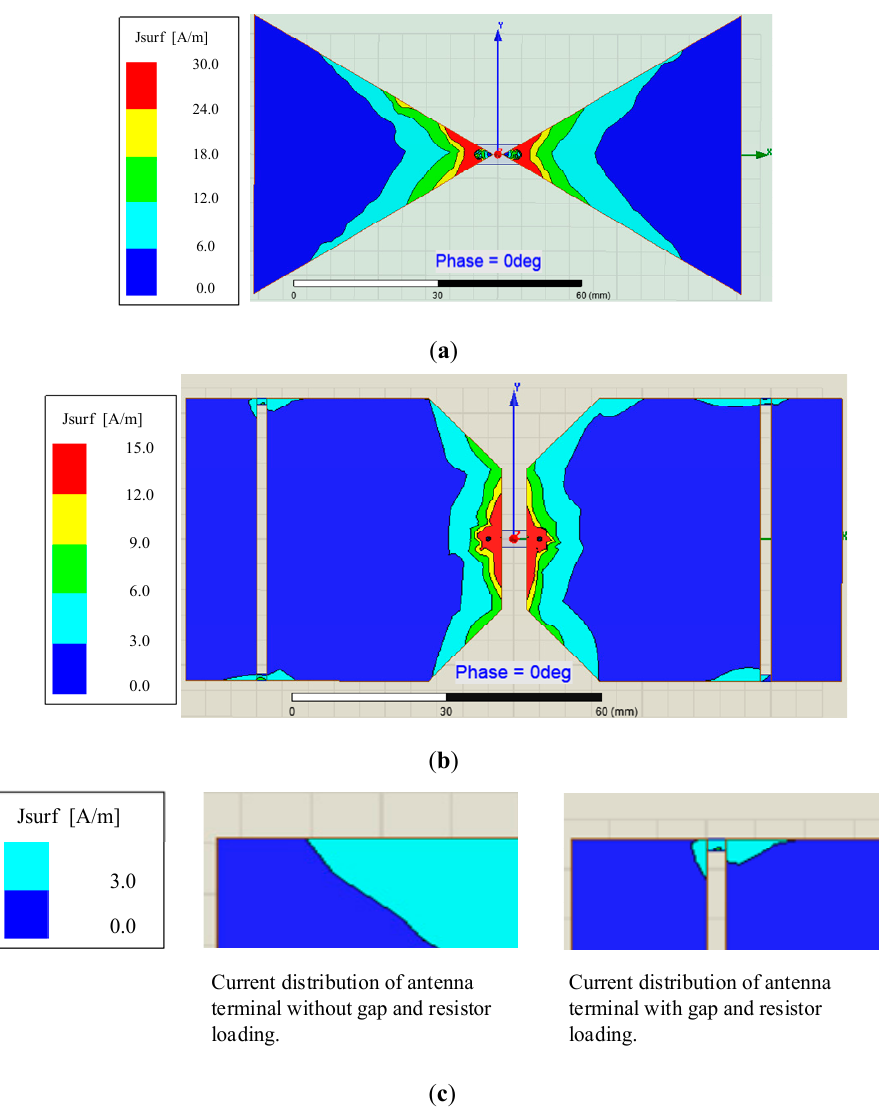
Figure 10. ( a ) Current distribution of the typical Bow-tie antenna; ( b ) Current distribution of the MOA;